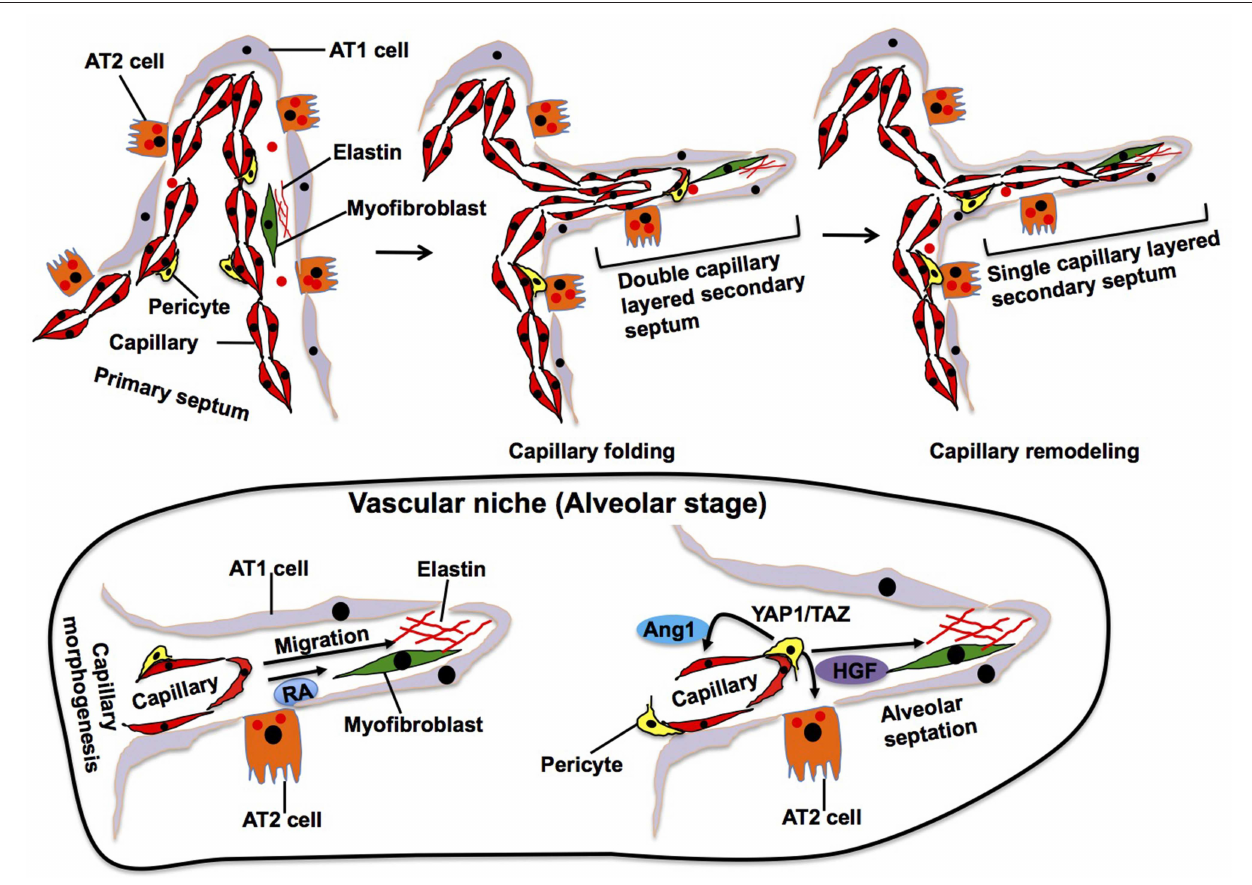
FIGURE 3 | Alveolar stage. During alveolarization, alveolar area significantly increases by secondary septation, in which secondary septa subdivide the terminal sac. Elastic fibers and myofibroblasts exist at the tip of growing secondary septa. Outer layer of the capillary folds up to drive extension of the septa, in which new double-layered capillary exists ( middle ). At the later stage of alveolarization, these double layers of the capillaries in the secondary septa remodel to form a single layer of the capillary to facilitate septal thinning for efficient gas exchange ( right ). Alveolar capillary ECs produce retinoic acid (RA) and stimulate synthesis of elastin in myofibroblasts, which in turn stimulate capillary morphogenesis. Dynamic changes in the mechanical environment stimulate mechanosenstivie YAP1/TAZ signaling in pericytes to release Ang1 and HGF that act on ECs and AT2 cells and stimulate